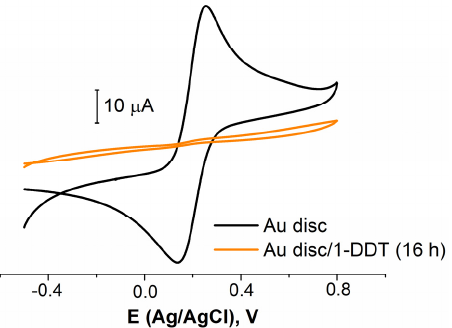
Figure 2. CVs for bare Au disc electrode (black curve) and covered with 1-DDT (colored curve). Solution: 0.025 M K 3/4 [Fe(CN) 6 ] in PBS (7.4). It can be seen that without reductive electrochemical pretreatment, the surface cov- erage is relatively low (60 ± 10%). Among the pretreatments applied, the best coverage value and the higher reproducibility were shown by both cyclic and potentiostatic modes in PBS. Thus, to maximize the surface coverage and reproducibility, it was decided to consistently use these pretreatments, as shown in the 7th row in Table 1. Table 2. Surface coverage of the gold electrode with DDT (16 h of immobilization) after different electrochemical pretreatments were applied. Electrochemical Treatment